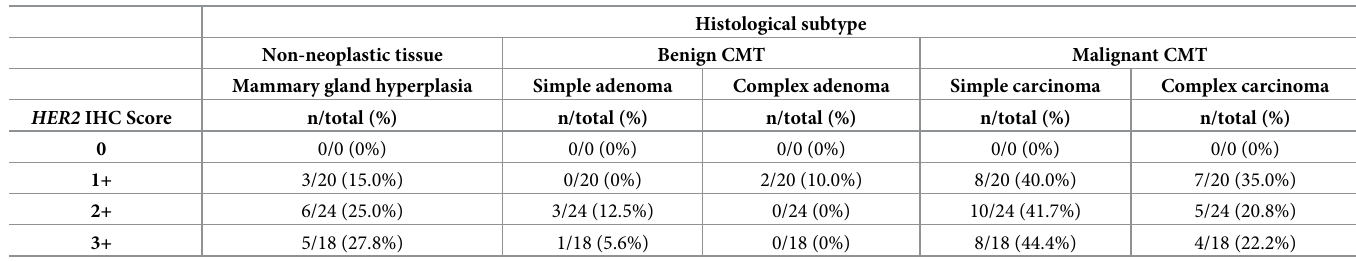
Table 1. The HER2 IHC score according to histological subtype of